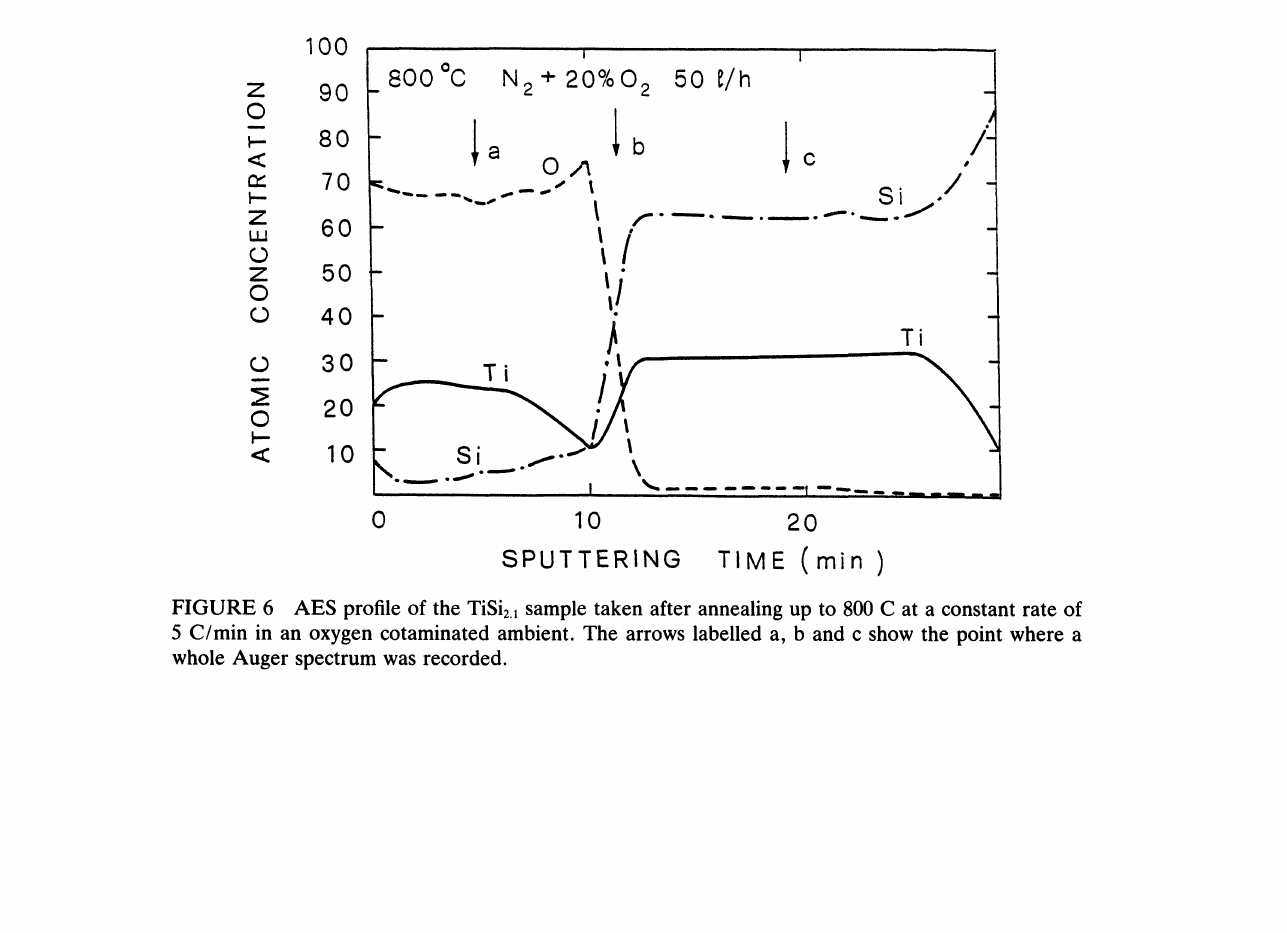
FIGURE 5 RBS spectra of the Si-capped sample as deposited and after annealing up to 800 C at a constant rate of 5 C/min in an oxygen contaminated ambient.